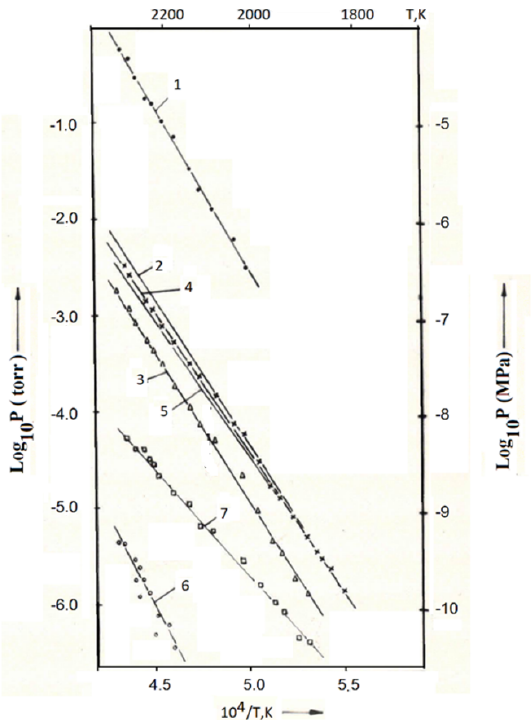
Figure 1. Dependence of partial pressures of gas phase components on temperature in Arrhenius coordinates over composition of sample 1 in Table 2 or No. 13 in Table 5: 1—nitrogen, 2—total pressure U + UO, 3—uranium monoxide, 4—uranium, 5—uranium from uranium nitride, 6—uranium mononitride, 7—uranium